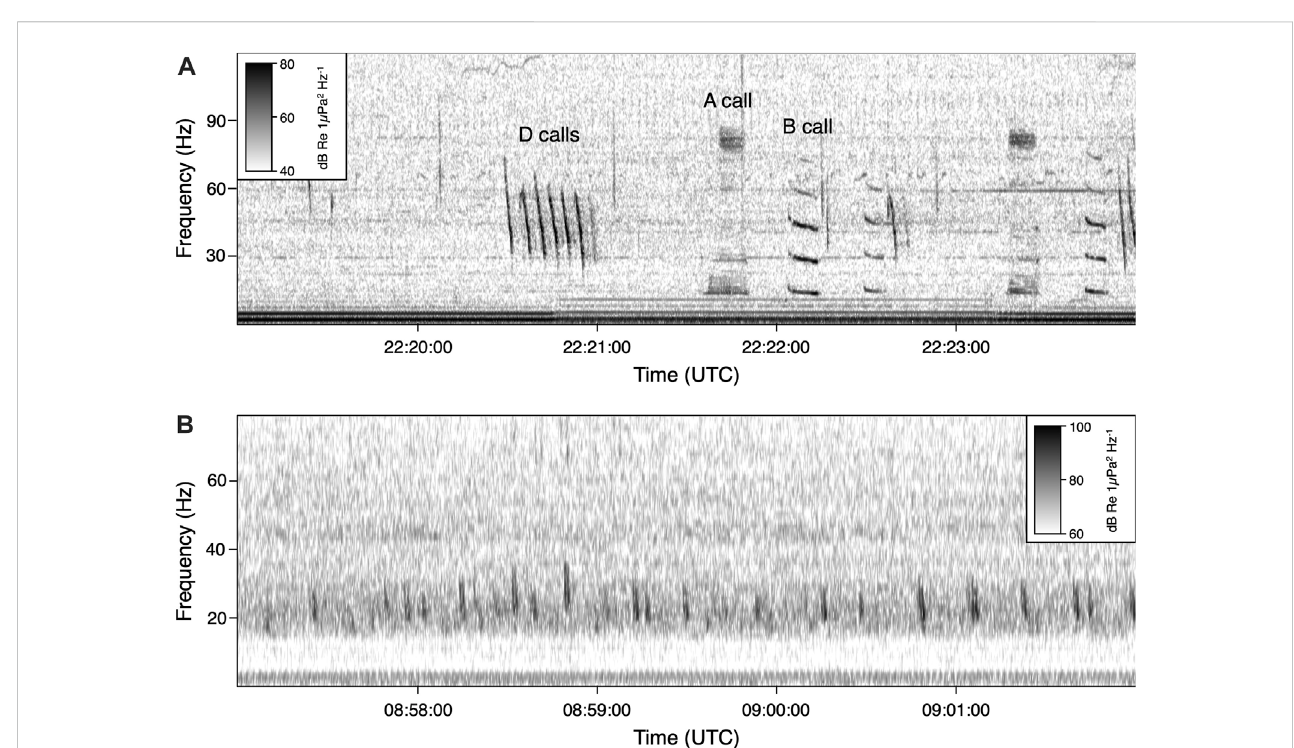
FIGURE 3 Spectrogram of (A) blue whale call types, including A, B, and D calls and (B) fi n whale song pulses, produced near 20 Hz. Note the differences in scale. Spectrograms were created with the following parameters: 8,192 FFT window size, 50% overlap for blue whale; 4,096 FFT window size, 95% overlap for fi n whale. The recording displayed in the top panel was taken on 18 June 2015 at the Channel Islands site. The recording in the bottom panel was taken on 3 October 2014 at the Olympic Coast site.